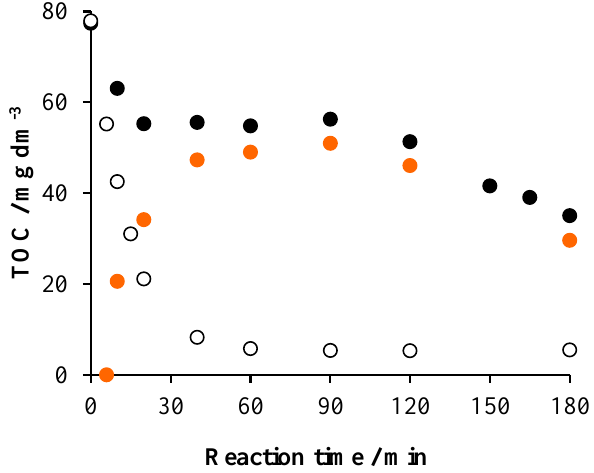
Figure 11. The change of the TOC as a function of time in the system